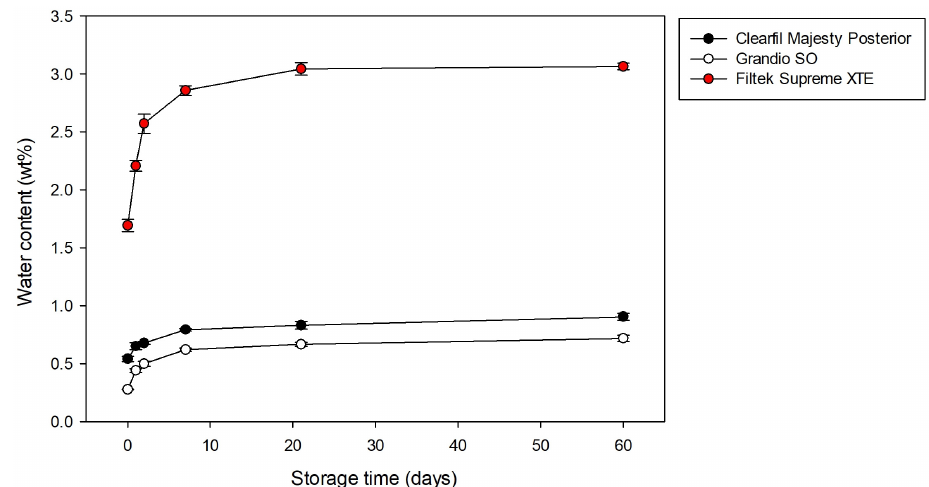
Figure 2. Means (standard deviation) of water content (in wt%) for each material evaluated as a function of storage times in water.